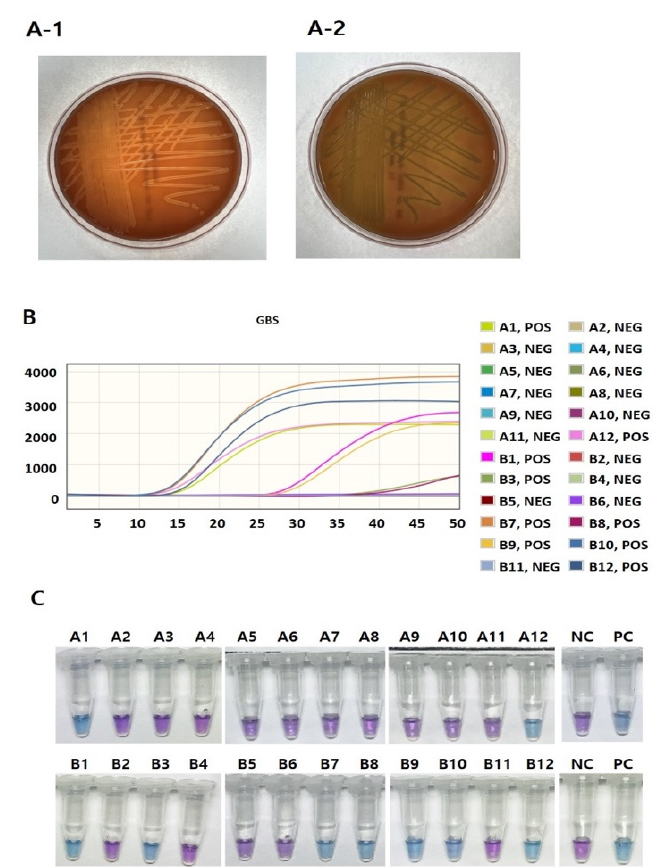
Figure 1. Representative results of the Culture, BD MAX™ and LAMP assay for the presence of GBS in the cultured broth samples. ( A-1 ) Sub-cultured colonies on blood agar plate after Lim Broth